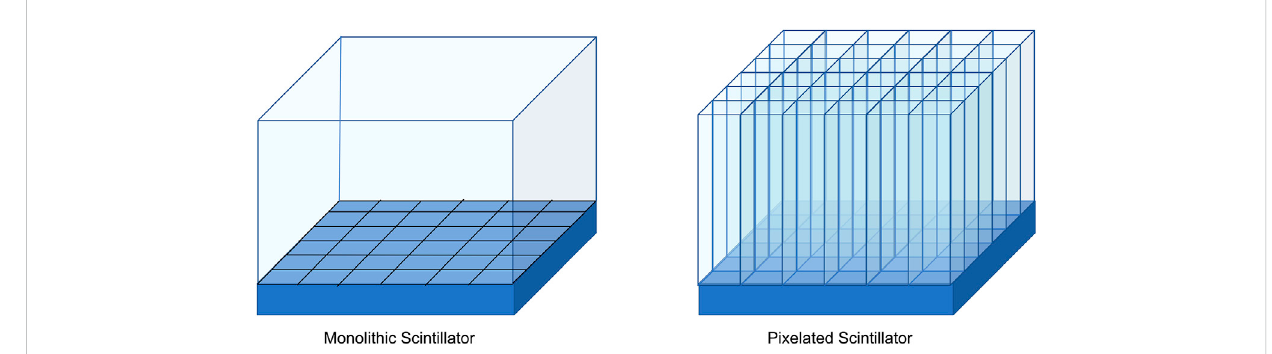
FIGURE 6 Monolithic scintillators are acontinuous slabof scintillator material. The photosensor array onthe bottom issegmented (Left). Pixelated scintillators are scintillator crystals cut to much smaller dimensions, then combined in a grid to make a complete detector. The photosensors in this fi gure are 1-to- 1 coupled with the pixelated scintillators (Right).